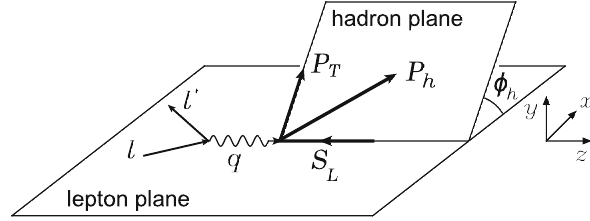
Fig. 1 ThekinematicalconfigurationfortheSIDISprocess.Theinitial and scattered leptonic momenta define the lepton plane ( x − z plane), while the detected hadron momentum together with the z axis identify the hadron production plane, the longitudinal spin of the nucleon is along the − z